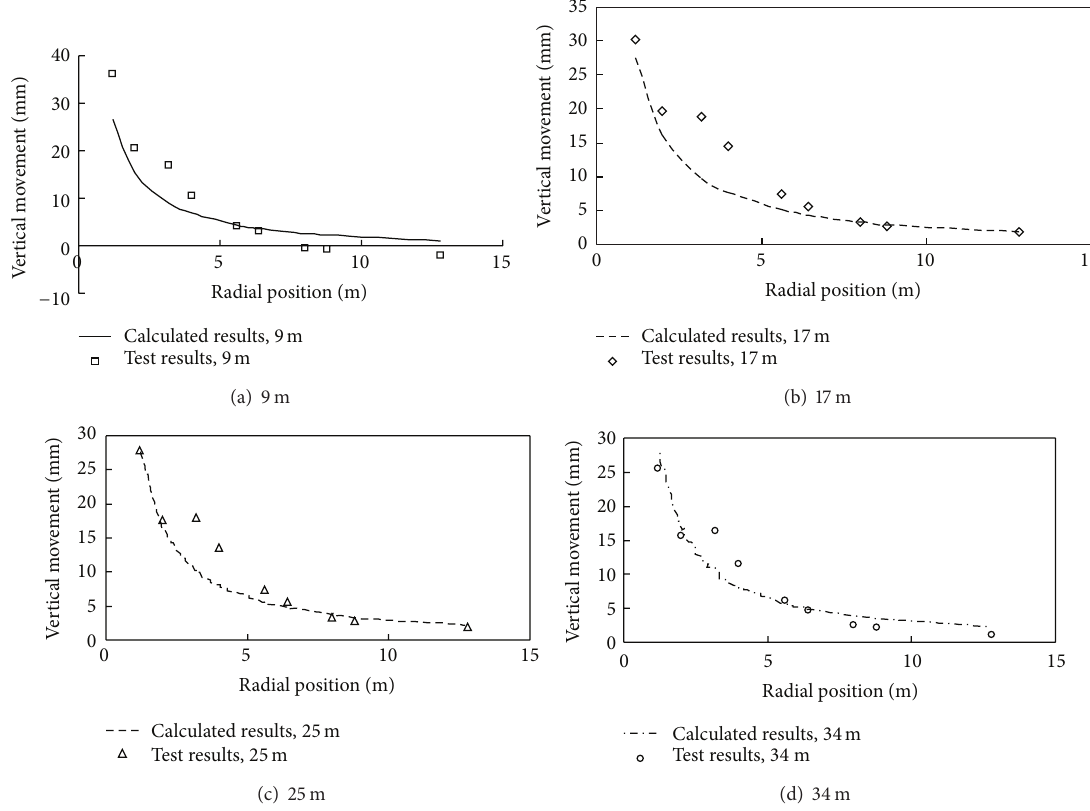
Figure 4: Observational data and calculated results of vertical